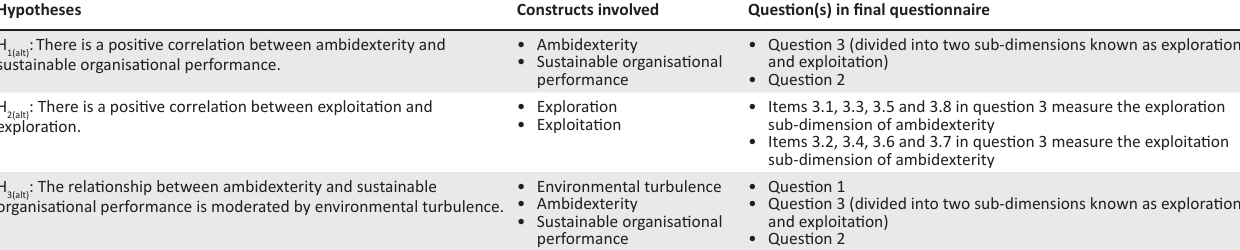
TABLE 1-A1: Hypothesis and survey questions matrix.